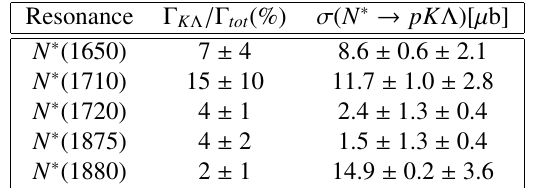
Table 2. Cross sections in units of µ b for the single positively charged resonances extracted from pp → pK Λ analysis (third column) [11] . The ratio of K Λ to total branching ratios derived from values in [12] is indicated in the second